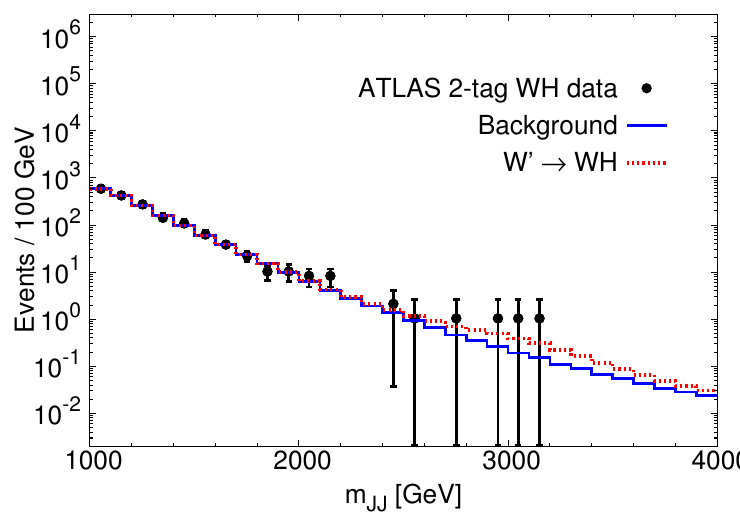
Figure 2 . The m JJ distribution of ATLAS 2-tag WH data points and the SM background (blue- solid histogram) are from ref. [1]. The W 0 ! WH contribution added to the background is indicated with the red-dashed histogram. The parameters are cos( (cid:12) (cid:0) (cid:11) ) = (cid:0) 0 : 3, tan (cid:12) = 2 : 41, g R = 1 : 358, (cid:0) other = 0 : 185 (cid:2) m W 0 , and m W 0 = 3 TeV, which gives (cid:27) ( pp ! W 0 ! WH ) = 9 : 7 fb, (cid:0) W 0 = W 0 0 : 3 (cid:2) m W 0